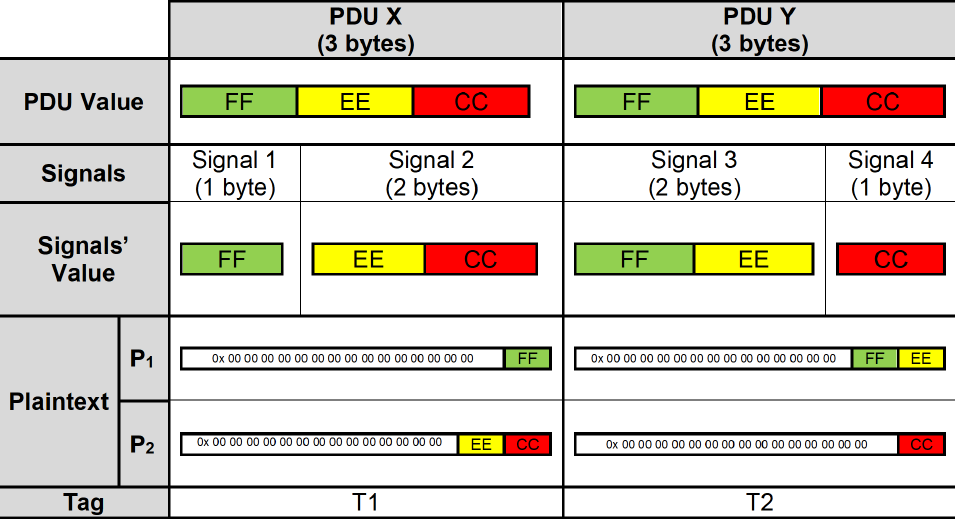
Figure 8. Two identical PDUs with different